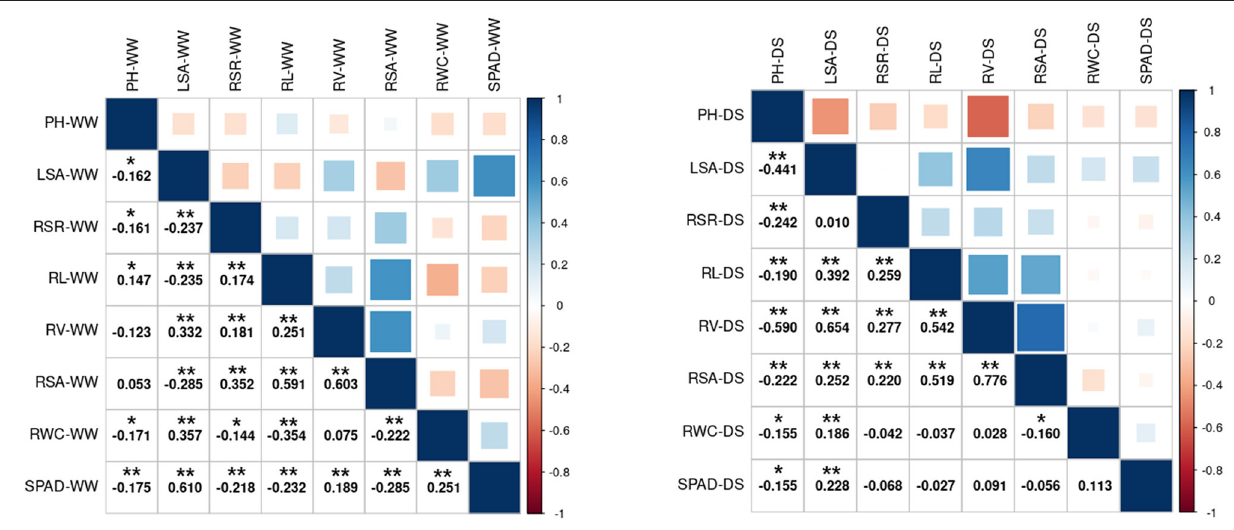
( Supplementary Figures 2 , 3 ; Supplementary Table 8 ). A total of 19, 44, and 33 SNPs were discovered by MLM, FarmCPU, and BLINK methods, respectively. For 8 phenotypic traits, LSA detected the most associated SNPs (27), followed by RWC detected 13, SPAD, RSR, and PH detected 12, 11, and 11, respectively. RL, RV, and RSA were detected 2, 4, and 3 SNPs, respectively. A total of 118 genes were found within the 20 kb of 80 significant SNPs, 85 of them were protein-coding genes ( Supplementary Table 9